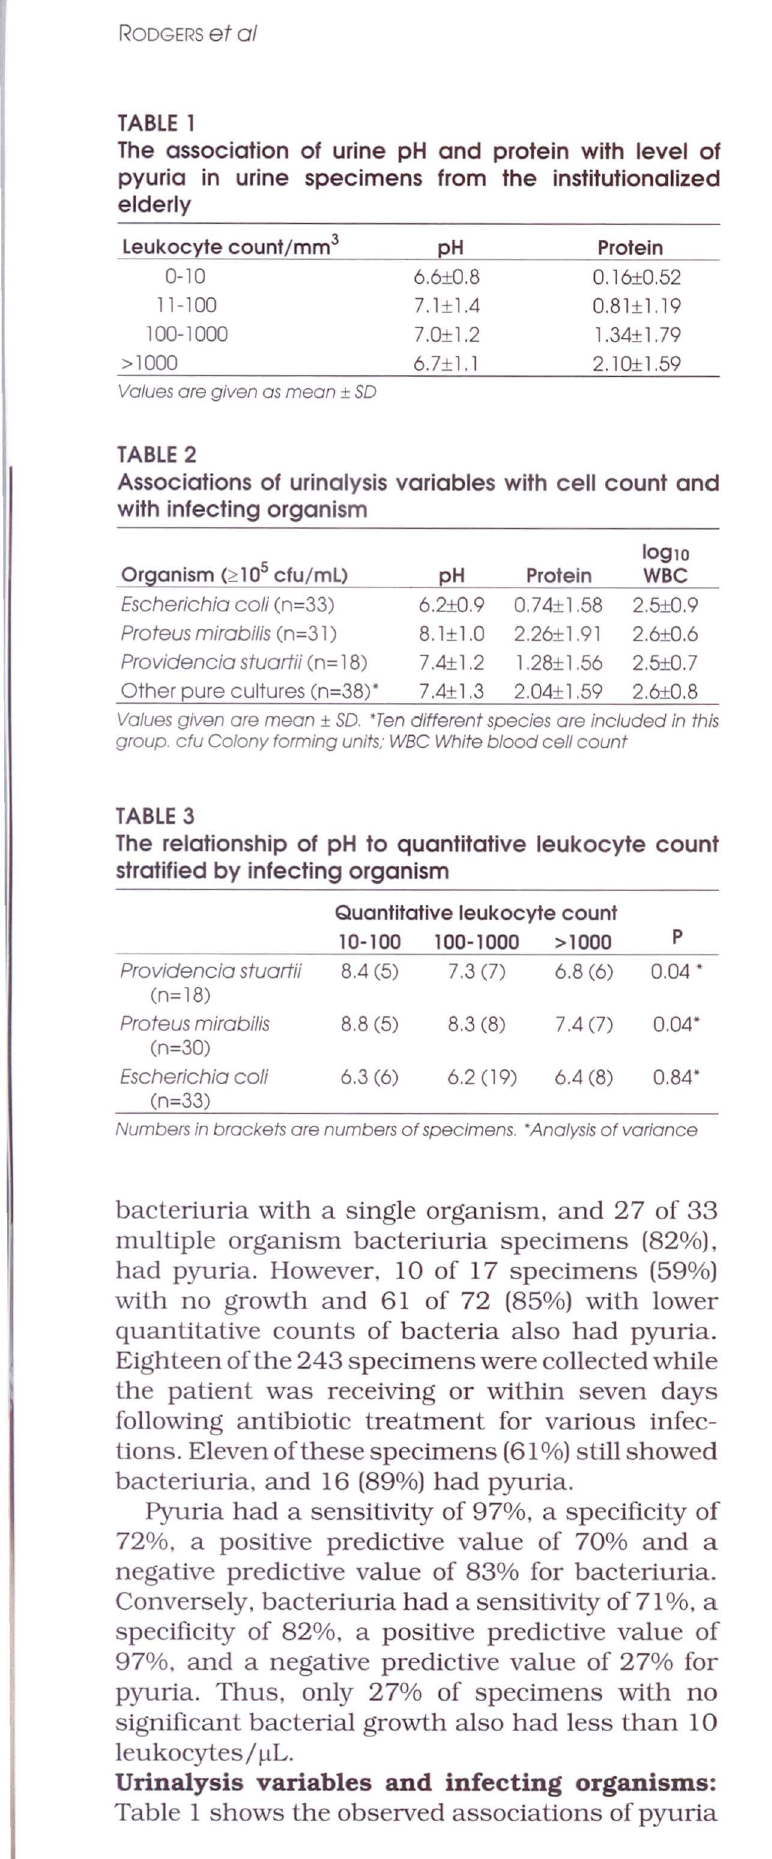
Values are given as mean ± SO